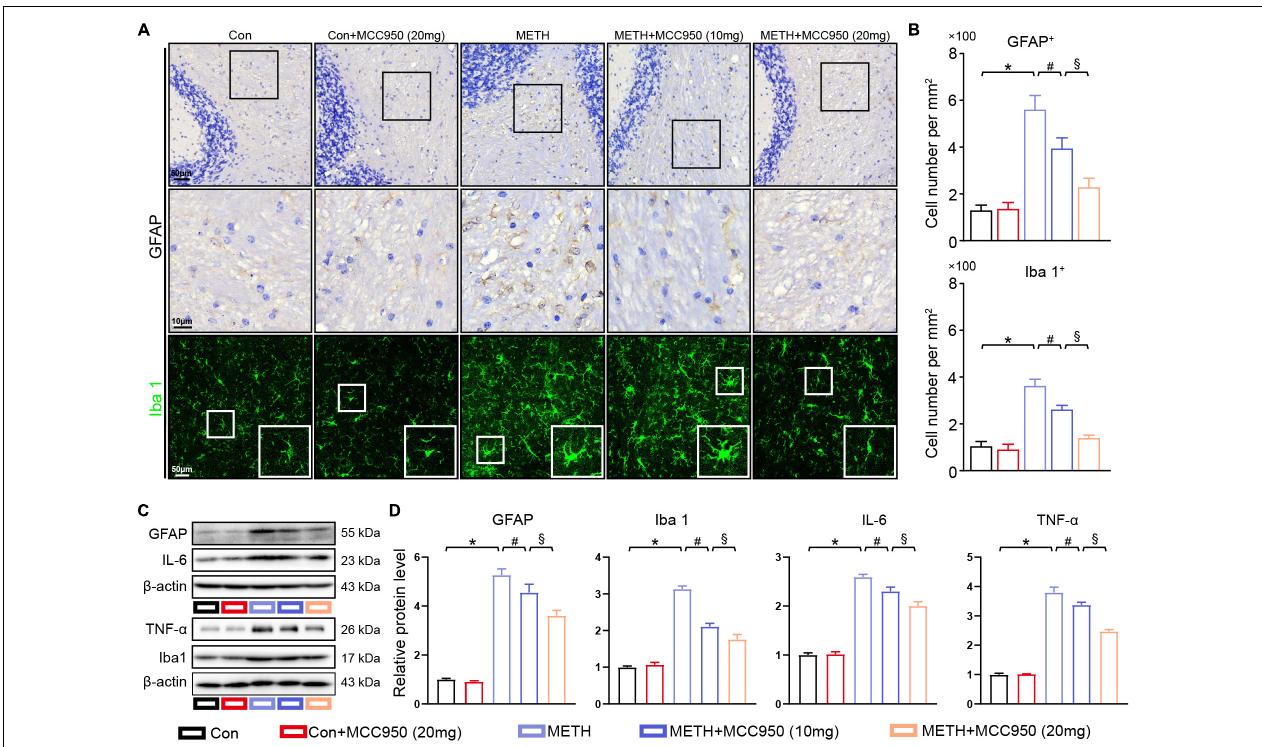
FIGURE 5 | MCC950 alleviated glial activation in cerebellar regions. (A) Representative images of GFAP IHC staining and Iba 1 IF staining in cerebellar regions. (B) Quantification of GFAP and Iba 1 positive cell number in cerebellar subregions. (C,D) Western blot and quantification for GFAP, Iba 1, IL-6, and TNF- α in cerebellum. n = 6 per group by one-way ANOVA and Bonferroni’s post-hoc analysis, * p < 0.05, compared with the Con group; # p < 0.05, compared with the METH-treated group; § p < 0.05, compared with the METH + MCC950 (10 mg)